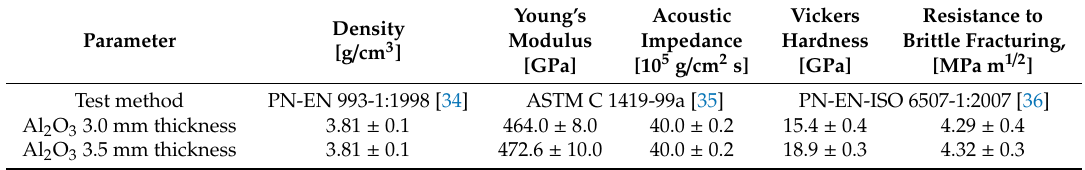
Table 2. Physical and mechanical parameters of Al 2 O 3 ceramics (CeramTec, Plochingen,